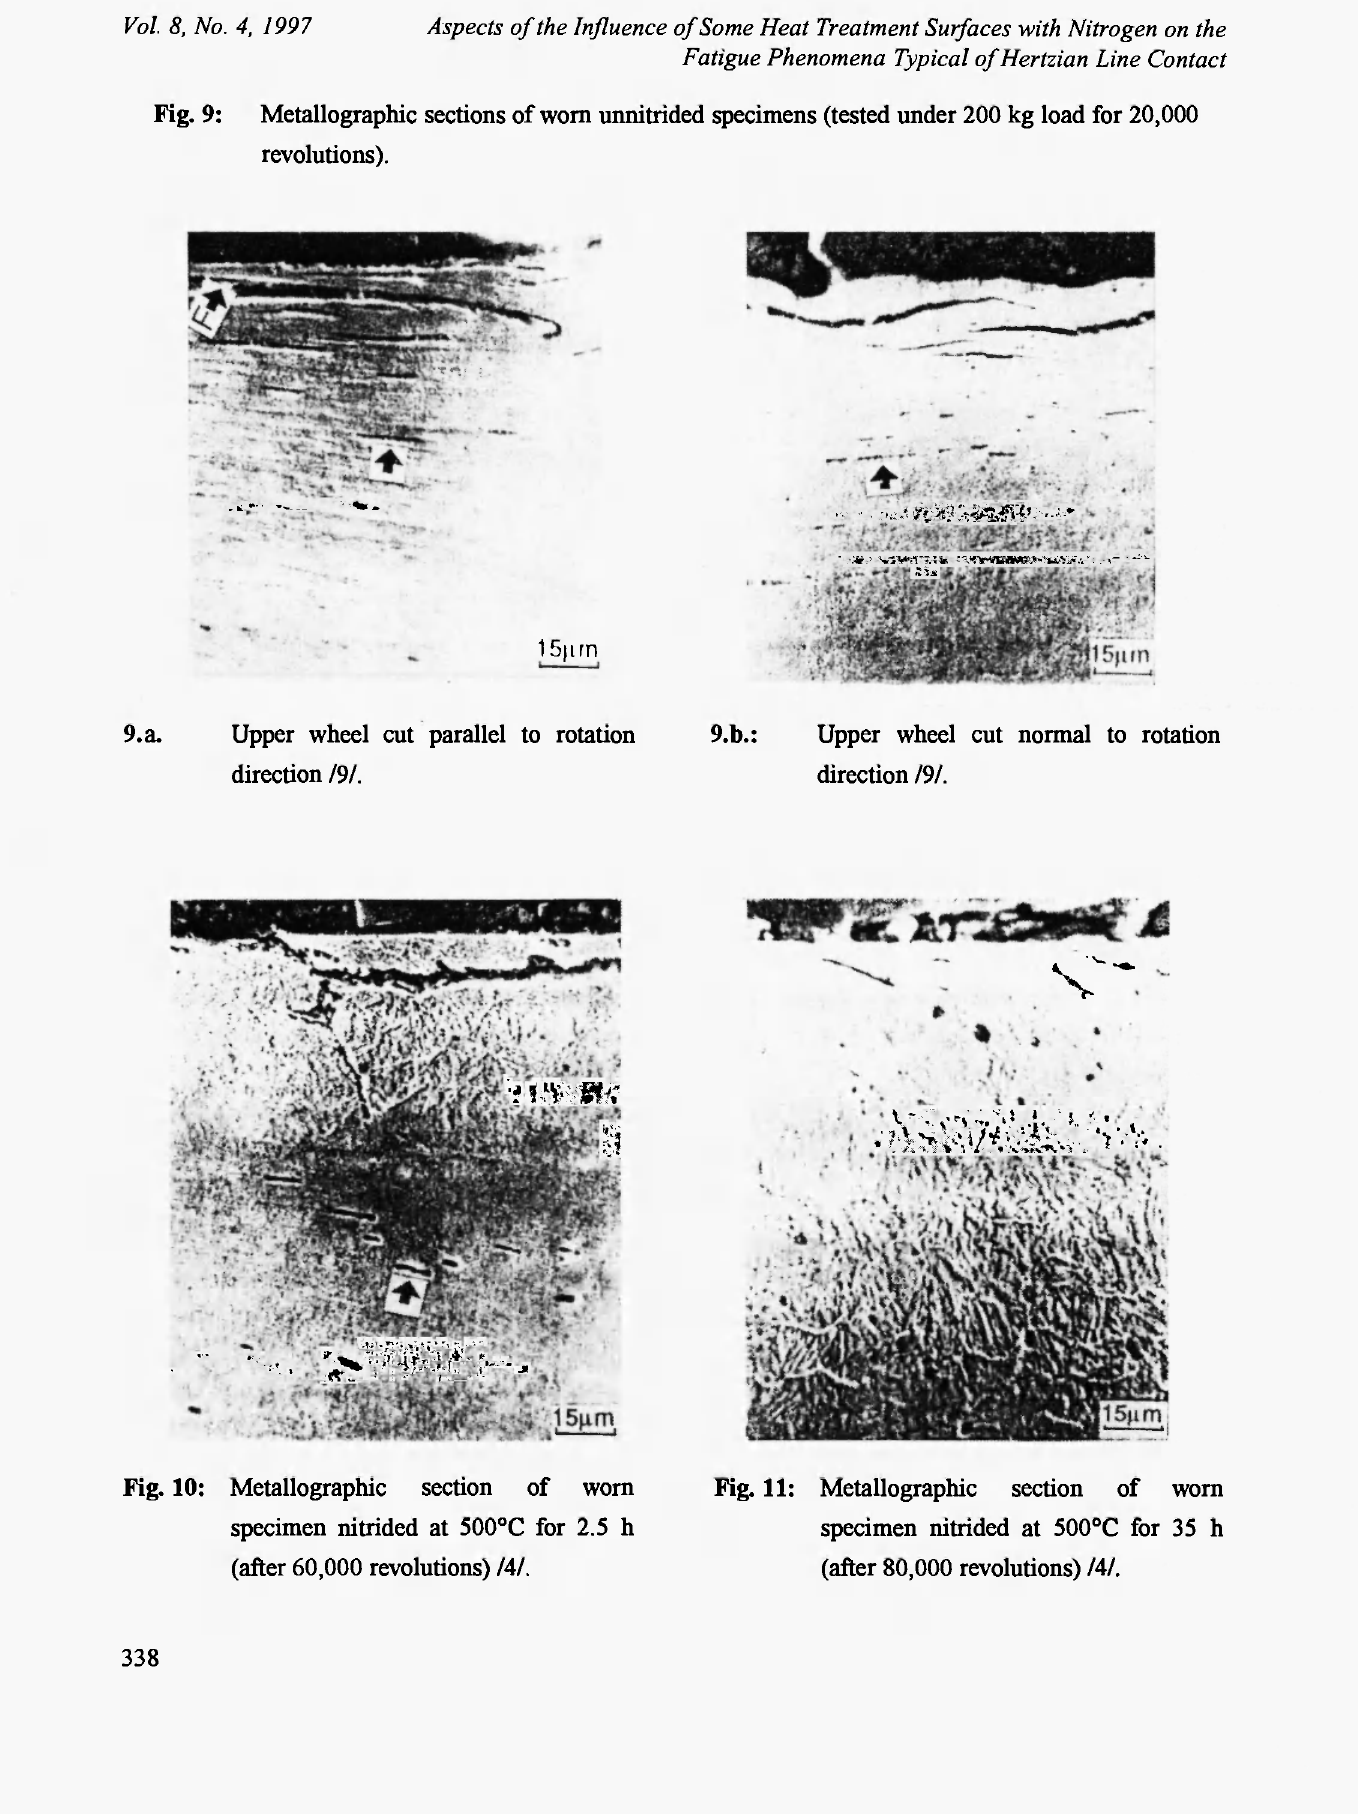
Fig. 9: Metallographic sections of worn unnitrided specimens (tested under 200 kg load for 20,000 revolutions).